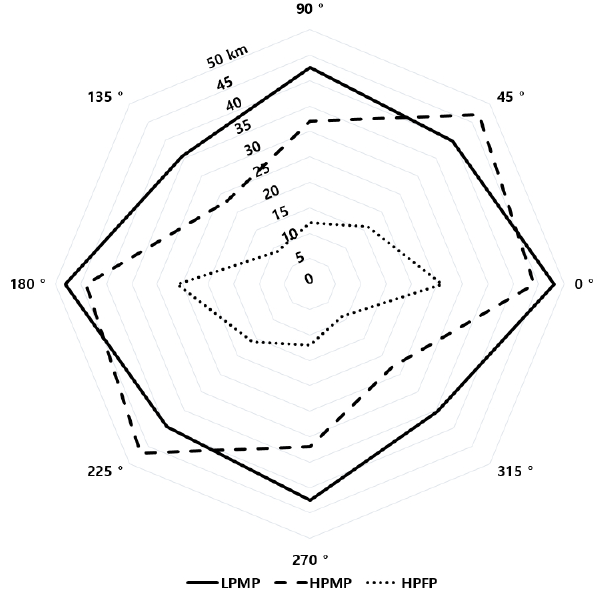
Figure 5. A radar chart representing the directional e -folding dis- tance (in km) for each precipitation type at the mode in the direc- tional histogram (not shown) depicting the number of cases accord- ing to the e -folding distance in different